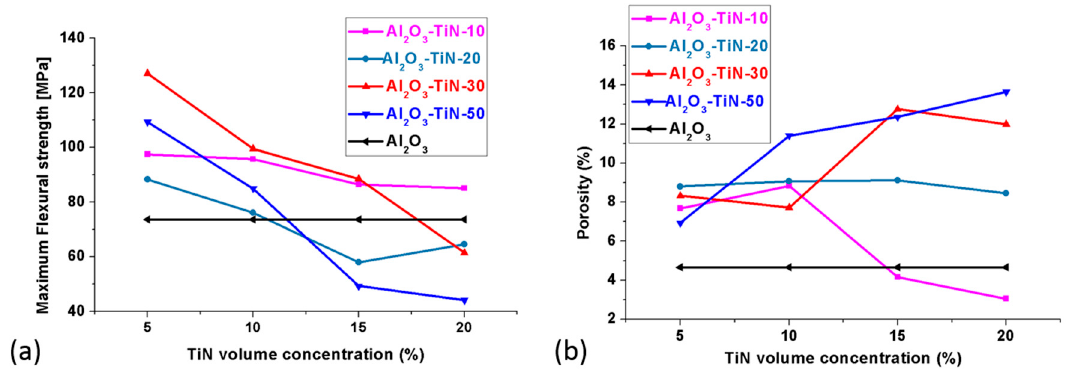
Figure 9. Comparison of the ( a ) maximum flexural stress and ( b ) porosity of the Al 2 O 3 –TiN-10, Al 2 O 3 –TiN-20, Al 2 O 3 –TiN-30 and Al 2 O 3 –TiN-50 composites with 5, 10, 15, and 20 vol % TiN addition, respectively.